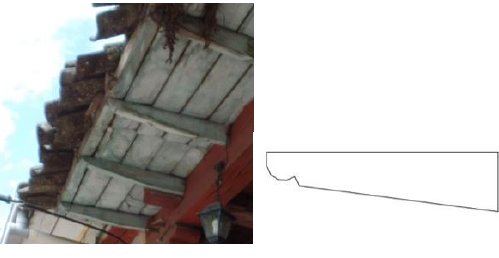
Figure 8. Mondillions, Nono, Ecuador,